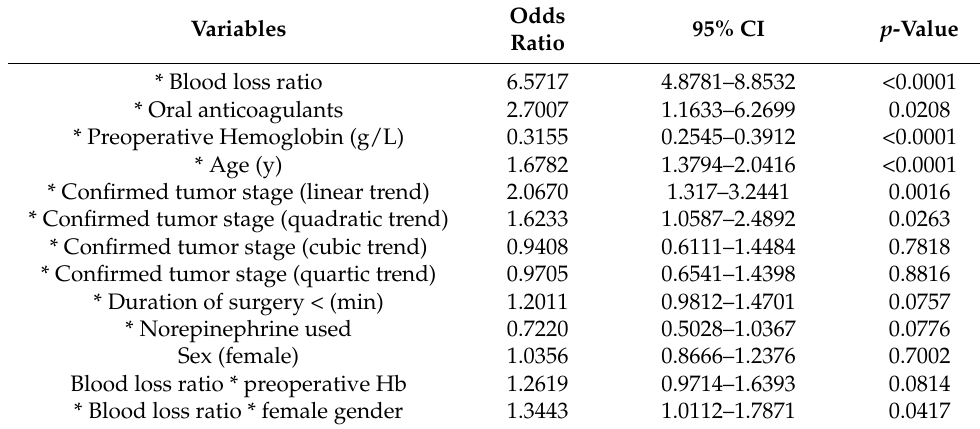
Figure 1. Effect plots for the predictors included in the final model (multiple logistic regression with adjusted odds ratio). Asterisks show the level of significance, *** for p < 0.001, ** for p < 0.01, * for p < 0.05. Table 2. Multivariate analysis of factors associated with the rate of early blood transfusion.